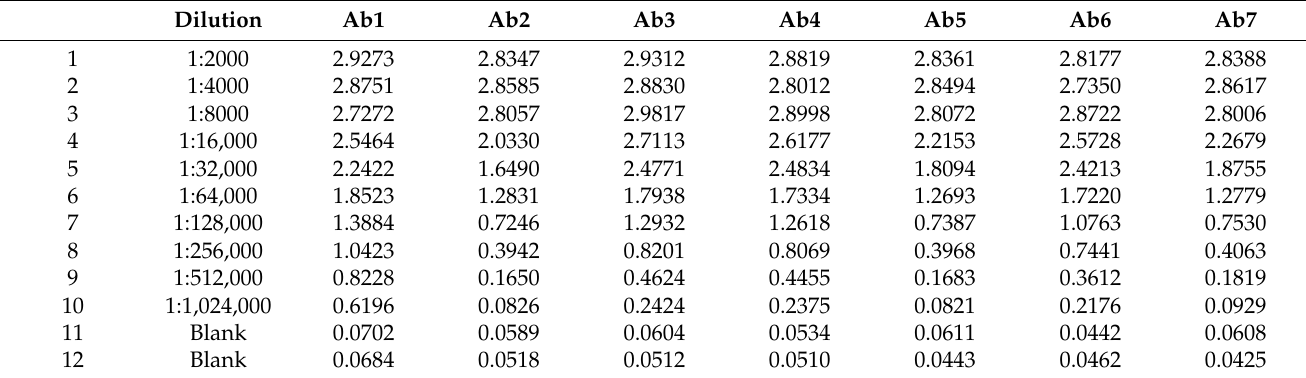
Table 2. Elisa results of antibody titer detection after